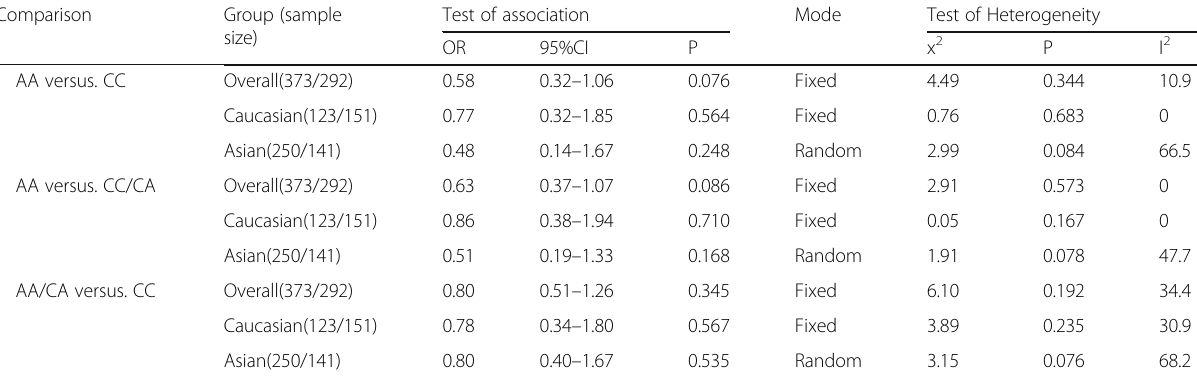
Table 3 The general results for the association between IL-10, IL-6 polymorphisms with Brucellosis risk (Continued) Comparison